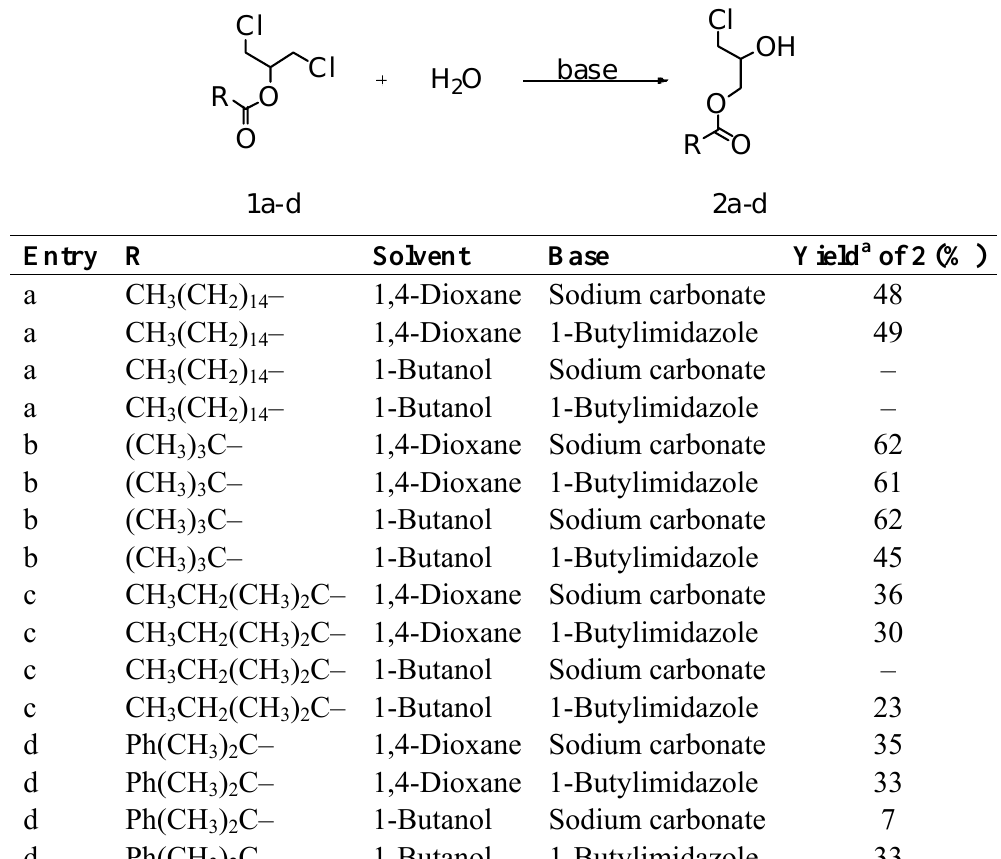
Table 1. Synthesis of 3-chloro-2-hydroxy-1-propyl esters using various solvents and bases. ClCl O